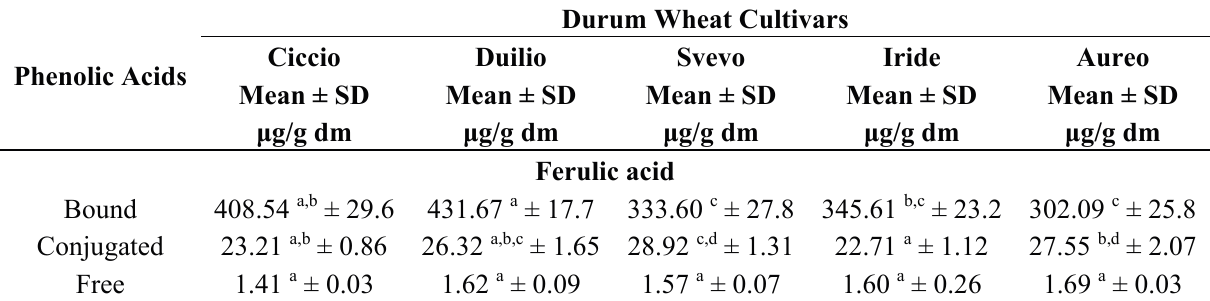
Table 1. Composition and content of individual bound, conjugated and free phenolic acids (µg/g dry matter) in the whole meal flour of five durum wheat, Italian, elite cultivars.